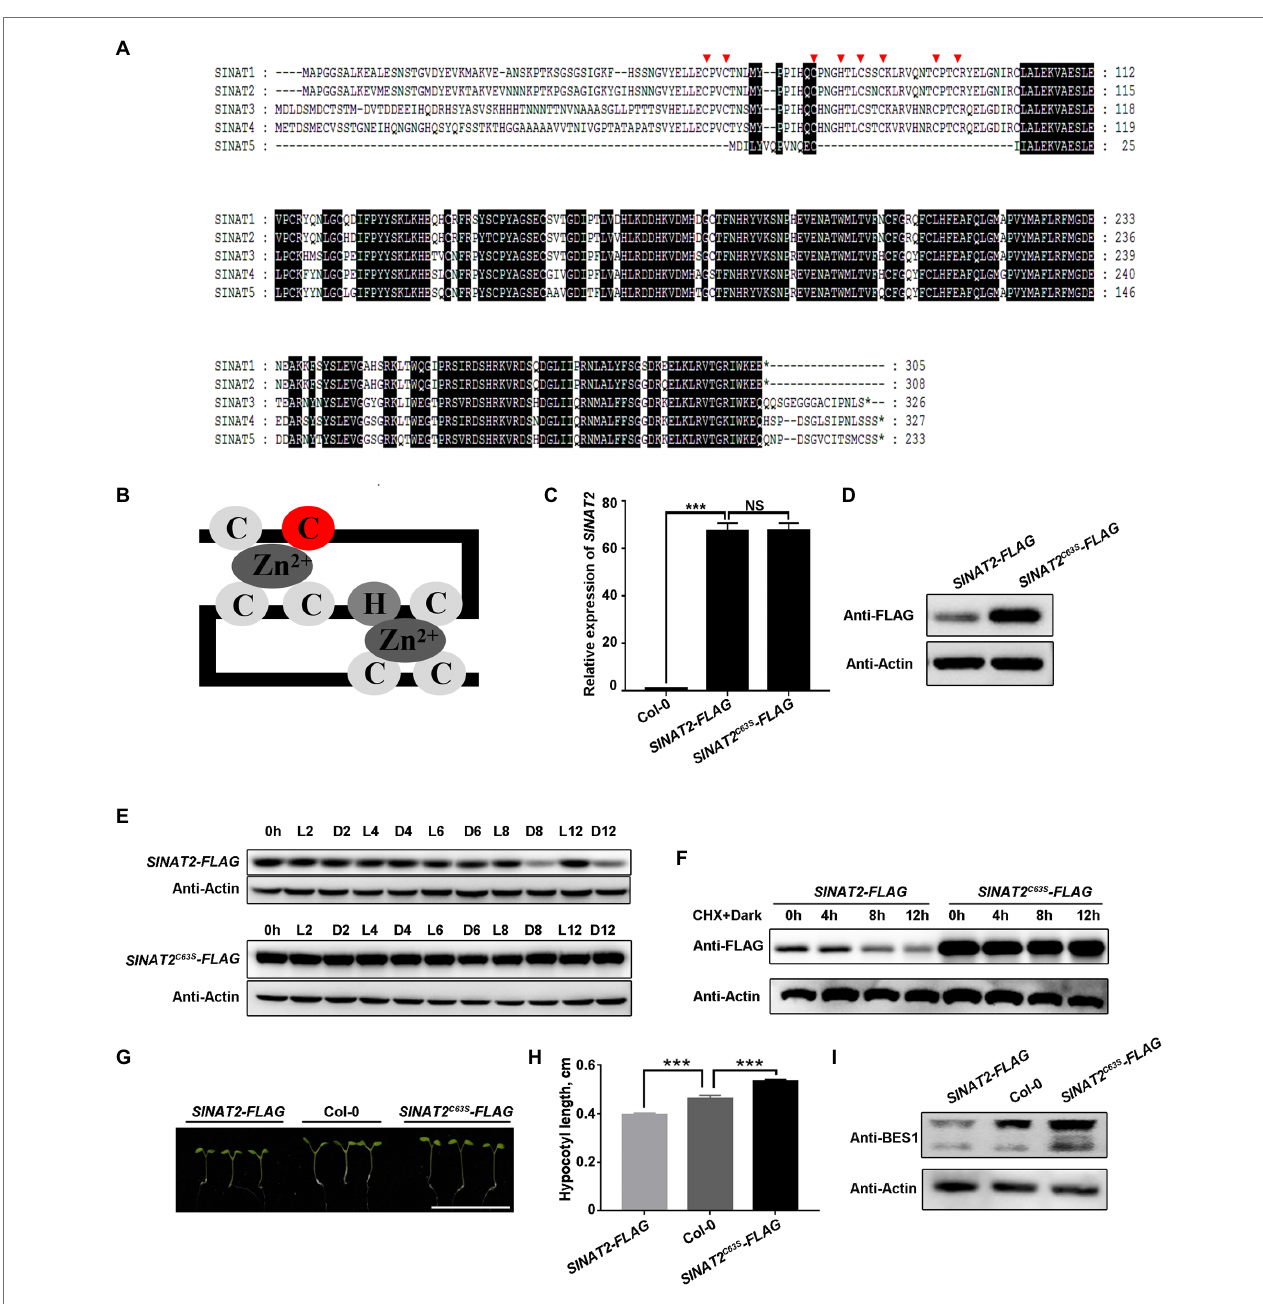
FIGURE 1 | SINAT protein degradation in the dark is self-regulated. (A) Protein sequence of five SINATs in Arabidopsis thaliana : SINAT1 (At2g41980), SINAT2 (At3g58040), SINAT3 (At3g61790), SINAT4 (At4g27880), and SINAT5 (At5g53360). The conserved regions are indicated with a black background. The red arrows mark the eight conserved residues in the RING domain. (B) Diagram of how the eight conserved amino acids form a zinc finger; the second cysteine residue (C63 in SINAT2; C67 in SINAT4) is marked in red. (C) SINAT2 transcript levels in Col-0 and the SINAT2-FLAG and SINAT2 C63S -FLAG transgenic lines. Data are means ± SD ( n = 3) and values of p were determined by Student’s t -test; *** p < 0.001; NS, non-significant, p > 0.05. (D) SINAT2 protein levels in the SINAT2-FLAG and SINAT2 C63S -FLAG transgenic lines. An anti-FLAG antibody was used to detect SINAT2 and an anti-Actin antibody was used to quantify the total protein. (E) SINAT2 protein levels under different light conditions. The SINAT2-FLAG and SINAT2 C63S -FLAG transgenic lines were grown in continuous light (L) for 5 days and were then kept in the light or transferred to the dark (D) for 2, 4, 6, 8, or 12 h. (F) The half-life of SINAT2 protein in the SINAT2-FLAG and SINAT2 C63S -FLAG lines. These lines were grown in continuous light (L) for 5 days and were then treated with cycloheximide (CHX) and transferred to the dark (D) for 4, 8, or 12 h. (G) Hypocotyl phenotypes of Col-0, SINAT2-FLAG , and SINAT2 C63S -FLAG lines. The scale bar corresponds to 1 cm. (H) Hypocotyl length of Col-0 and the SINAT2-FLAG and SINAT2 C63S -FLAG lines. Error bars indicate the SE ( n = 30). Statistical significance was determined by Student’s t -test. *** p < 0.001. (I) BES1 protein levels in Col-0 and the SINAT2-FLAG and SINAT2 C63S -FLAG lines. Anti-BES1 antibody was used to detect BES1 protein; anti-Actin antibody was used to quantify the total